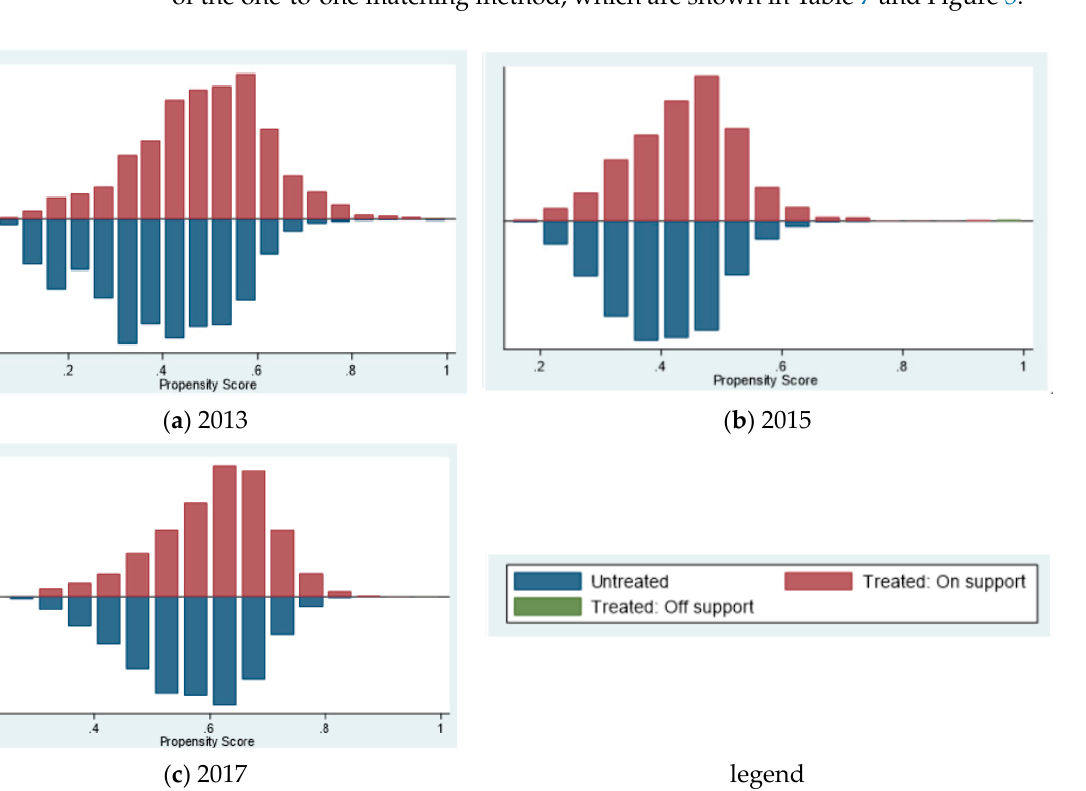
Figure 3. PSM method balance test chart: ( a ) Describe 2013; ( b ) Describe 2015; ( c ) Describe 2017.